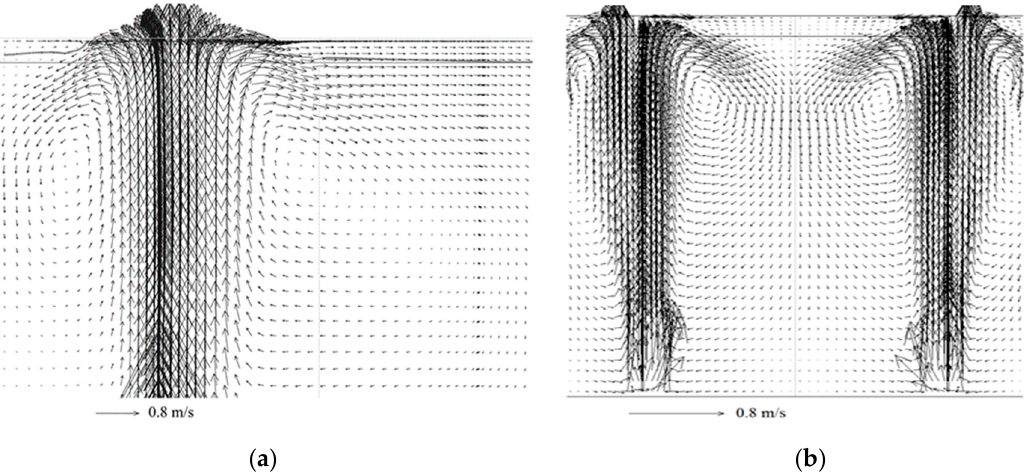
Figure 5. Velocity fields are shown in the plane of symmetry of the ladle furnace ( a ) single plug gas injection, the liquid metal shows two recirculation on the sides of the single nozzle, generated by the drag of the bubbles on the liquid steel, ( b ) dual plug gas injection creates two plumes with two circulating loops on each side of each plume. The flow patterns in the slag layer are different for both injections (single or dual).